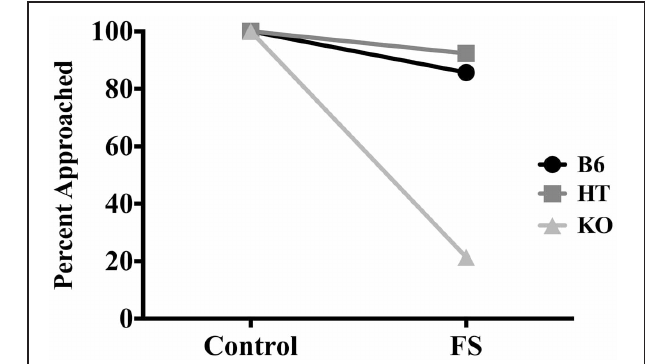
FIGURE 2 | Percentage of wild-type C57BL/6J (B6), heterozygous (HT), and β -E knock-out (KO) mice in each group that approached the almond slice at least once during the 5-min NSF test. Significant correlations between experimental variables were determined by Two-Way chi-square tests of independence. Whether or not the almond was approached depended on stress condition, genotype, and interaction of genotype and stress condition (all p -values ≤